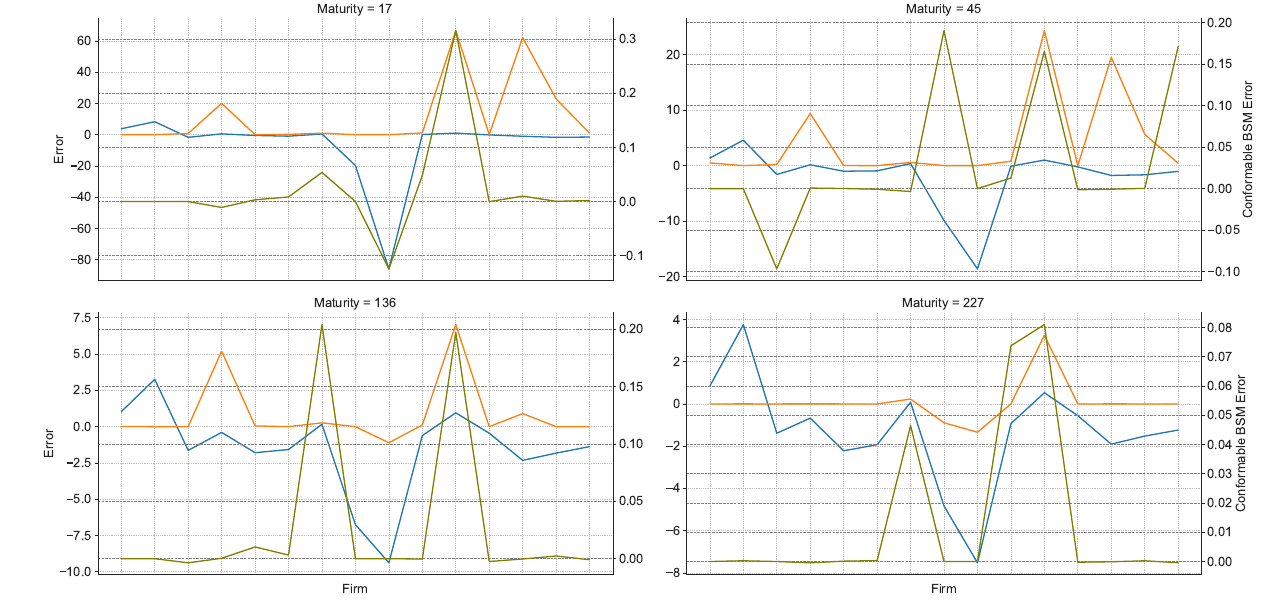
Figure 2. Percentage error for each firm (x axis), model and contract. The blue lines corresponds to the Black–Scholes model, the orange line to the Fractional Black–Scholes, and the olive line to the conformable Black–Scholes whose scaled is signalled on the right axis or each plot.